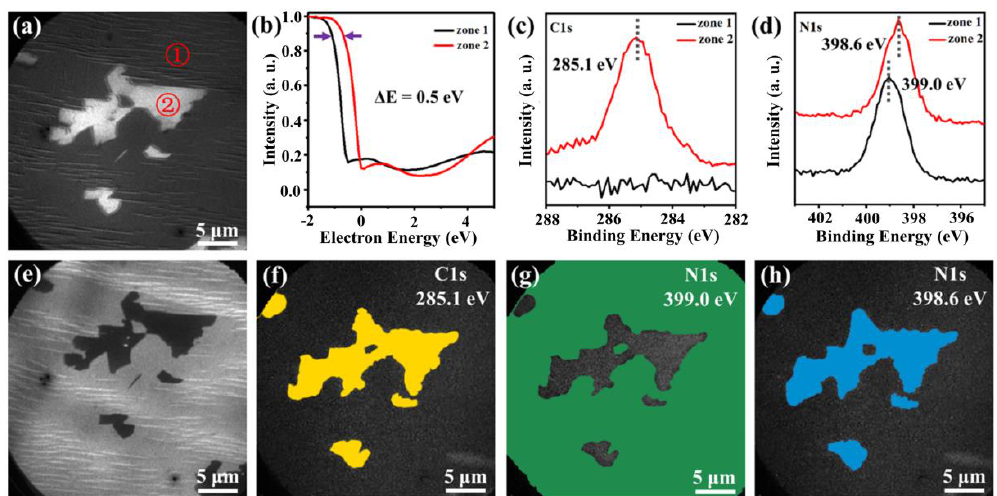
Figure 3. ( a ) LEEM and (e) PEEM images of the surfaces segregated at 650 °C ( b ) LEER spectra acquired from zone 1 and zone 2, respectively. ( c ) C 1s and ( d ) N 1s core level spectra ( hv = 500 eV) measured from zone 1 and zone 2, respectively. ( f – h ) XPEEM images at C 1s core levels with binding energies of 285.1 eV, and N 1s core levels with binding energies of 399.0 and 398.6 eV ( hv = 500 eV), respectively. The distribution of related elements with the certain chemical state is color-coded and the black contrast represents background signals, and those initial data are shown in Figure S1 in the supplementary materials.